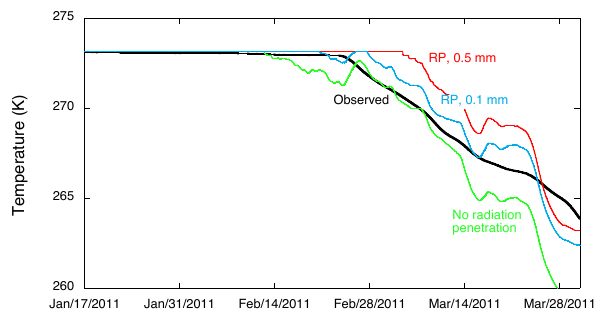
Fig. 9. Comparison of observed cumulative height change and mod- eled cumulative melt at AWS 14, for different model settings of radiation penetration. Observed height change (converted to mm w.e. assuming a density of 400kgm − 3 ) shown in black; model without radiation penetration in green; model with radiation pen- etration (0.1mm snow grain radius) in blue; model with radiation penetration (0.5mm snow grain radius) in red. Dotted lines indicate subsurface melt; dashed lines indicate surface melt; and solid lines indicate total melt ( = surface + subsurface